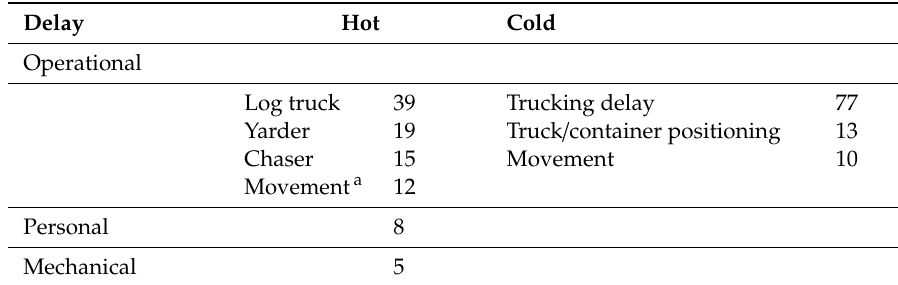
Table 3. Delays (in percentage) of loader observed during the various stages of the hot and cold loading arrangements using task sampling